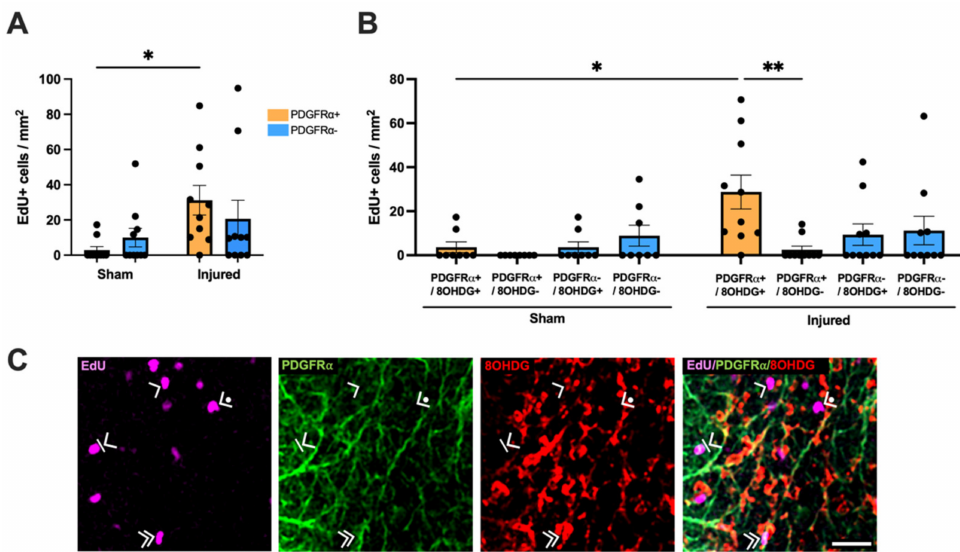
Figure 5. Effect of injury on proliferation and oxidative DNA damage within OPCs. ( A ) The relative densities of EdU+ PDGFR α + and EdU+ PDGFR α − OPCs were quantified. Statistical analysis by two-way ANOVA and Tukey post hoc tests. ( B ) The relative densities of EdU+ cells colocalized with PDGFR α and 8OHDG were quantified. Statistical analysis by three-way ANOVA with Tukey post hoc tests. Graphs display individual data points overlaid on a bar displaying the mean ± SEM. n = 8–10 rats per group. ( C ) Representative images illustrating EdU+ PDGFR α + 8OHDG+ OPCs (in- dicated by >>), EdU+ PDGFR α + 8OHDG − OPCs (indicated by >|), EdU+ PDGFR α − 8OHDG+ cells (indicated by >), EdU+ PDGFR α − 8OHDG − cells (indicated by • >) are shown, scale bar = 25 µ m. No outliers were removed for any outcome measure. Significant differences are indicated by * p ≤ 0.05, ** p ≤